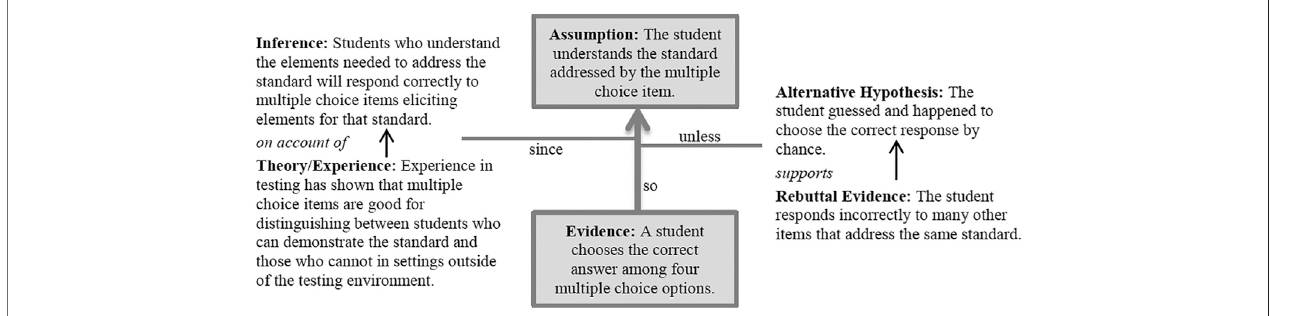
FIGURE 4 | A Toulmin diagram for an aspect of an example multiple choice